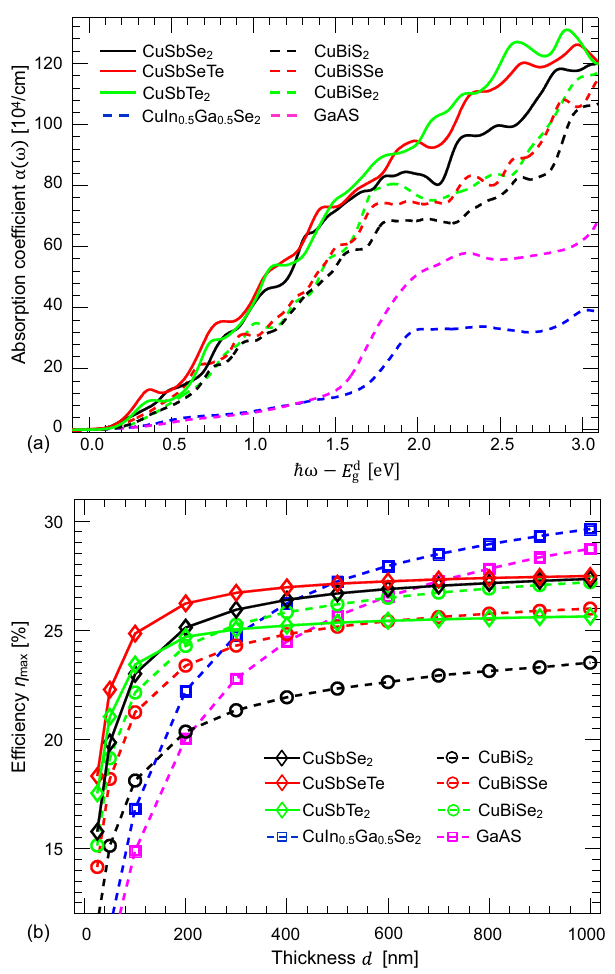
(a) The absorption coefficients α ( ω ) of CuSbSe 2 , CuSbSeTe, CuSbTe 2 , CuBiS 2 , CuBiSSe, and CuBiSe 2 on the energy scale ( (cid:2) ω − E d ) and with a 0.30 eV Lorentzian broad- g ening. These compounds exhibit much stronger near-gap- energy absorption compared to the traditional absorbers GaAs ( E g ∼ 1.41 eV with HSE06) and CIGSe (50% alloying: E g ∼ 1.30 eV). (b) The corresponding maximum solar energy effi- ciency η max demonstrates high efficiency of CuSb(Se,Te) 2 and CuBi(S,Se) 2 alloys for very thin films of d < 400 nm (see also Tab.